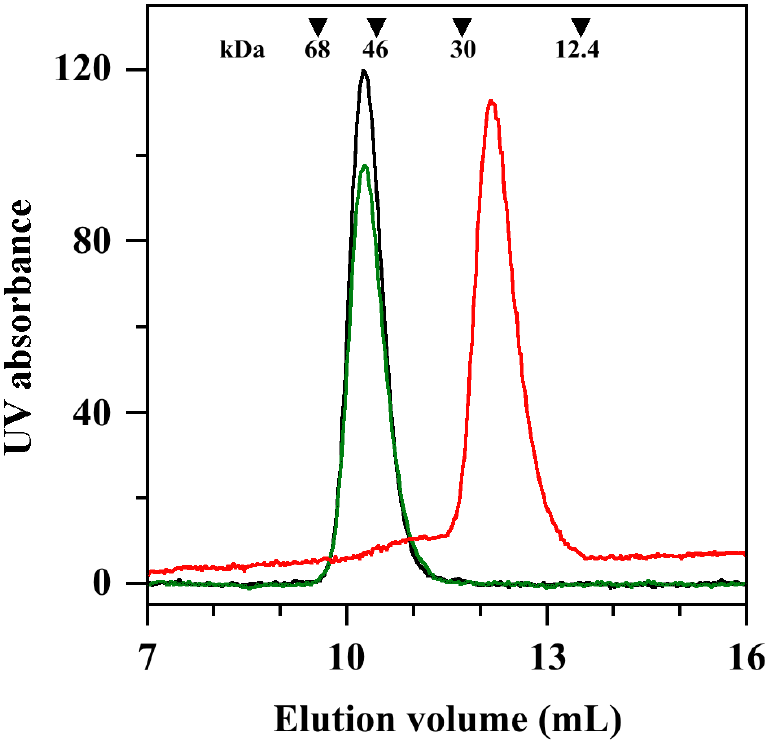
Figure 4. Effect of ALS-31 on gel-filtration of Sm SOD. A protein sample of Sm SOD, 63 µ M in 20 mM Tris HCl buffer, pH 7.8, supplemented with 150 mM KCl and 1% ( v / v ) DMSO, was untreated or incubated at room temperature for 20 min with 200 µ M ALS-31 . The protein sample was then loaded on a Superdex 75 10/300 column and the elution profile was followed by a continuous absorbance monitoring at 280 nm. Untreated Sm SOD (black line); Sm SOD incubated with 200 µ M ALS-31 without (green line) or after the addition of 200 µ M ALS-31 in the elution buffer (red line). The elution volumes of bovine serum albumin (9.56 mL), egg albumin (10.44 mL), carbonic anhydrase (11.72 mL) and cytochrome c (13.51 mL), used as standard protein markers, are indicated by inverted triangles. Their position was unaffected by the addition of ALS-31 in equilibration and elution buffer.